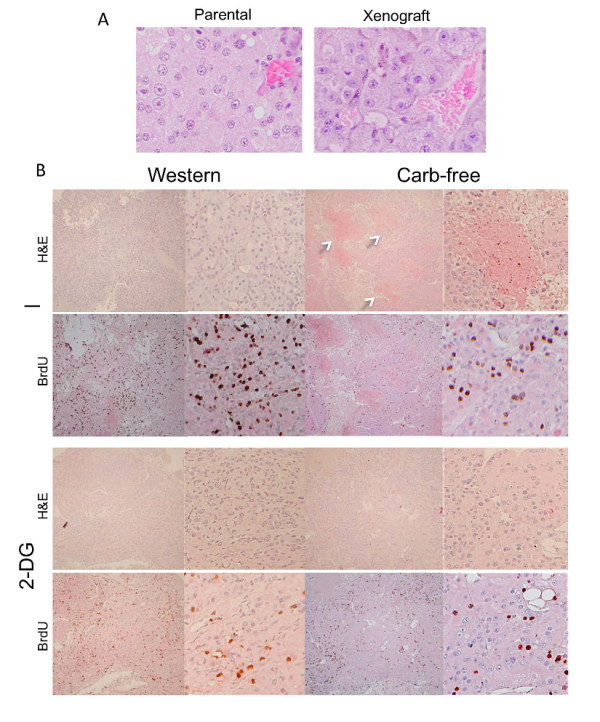
Morphologic appearances of LEF2 tumor xenografts. A) Comparison of parental renal cell tumor from an Eker rat and a LEF2 xenograft. Shown are representative sections of H&E-stained, formalin-fixed tumors. Magnification 400×. B) Representative microscopic appearances of the LEF2 xenografts at time of sacrifice from each treatment group. Shown are low- (left) and high- (right) magnification views of the H&E and BrdU staining for each of the 4 treatment groups. Note the hemorrhagic and necrotic zones (arrows) in the Carb-free sample.